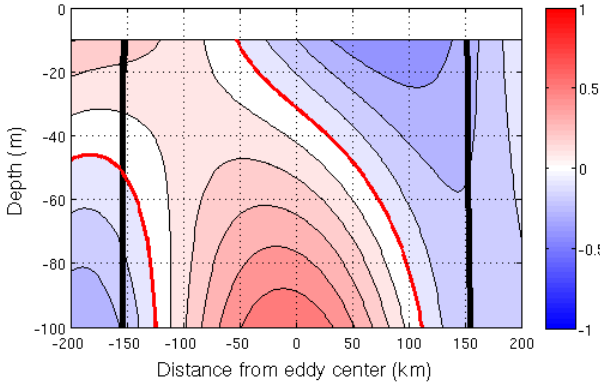
Figure 4. Zonal Figure 5. Map of the mean perturbation wind speed ( V 0 color the mean perturbation wind speed ( V' color contours) and T' (black contours) and T 0 (black contours – c.i. 0.01 ◦ C) obtained from contours – c. i. 0.01ºC) obtained from the 16 Agulhas rings observed the 16 Agulhas rings observed between January 2005 and Decem- ber 2008. The thick black line represents the 0 ◦ C T 0 , the continuous between January 2005 and December 2008. The thick black line lines positive values and the dashed lines negative values of T 0 . The represents the 0ºC T' , the continuous lines positive values and the figures’ axes represent the distances from the eddy centers normal- dashed lines negative values of T' . The figure axis represent the ized by the eddy distances from the eddy centers normalized by the eddy diameters.